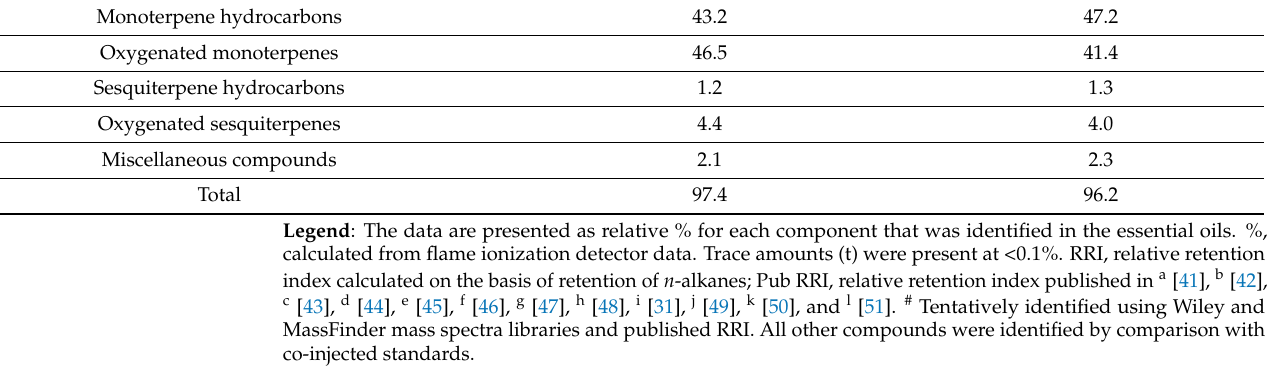
Table 2. Enantiomeric distribution of G. squarrosa essential